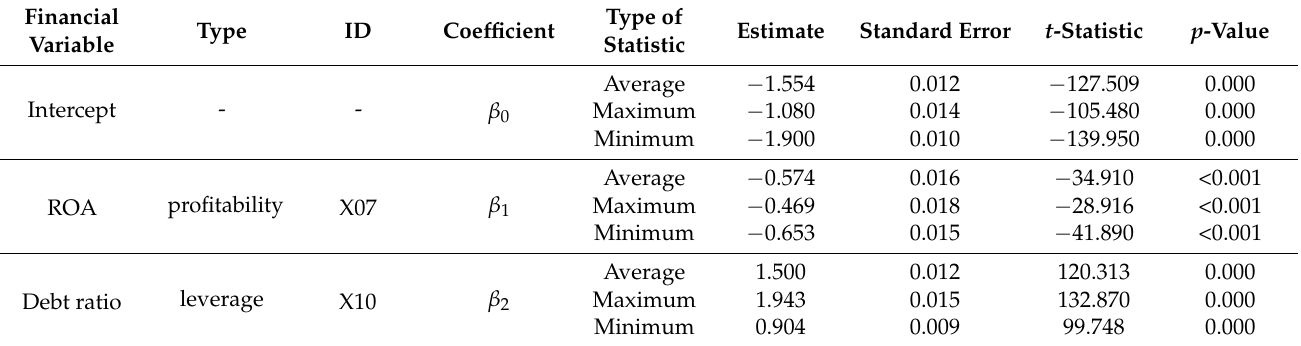
Table 6. Descriptive statistical summary of the estimated coefficients and their statistical significance of all 50